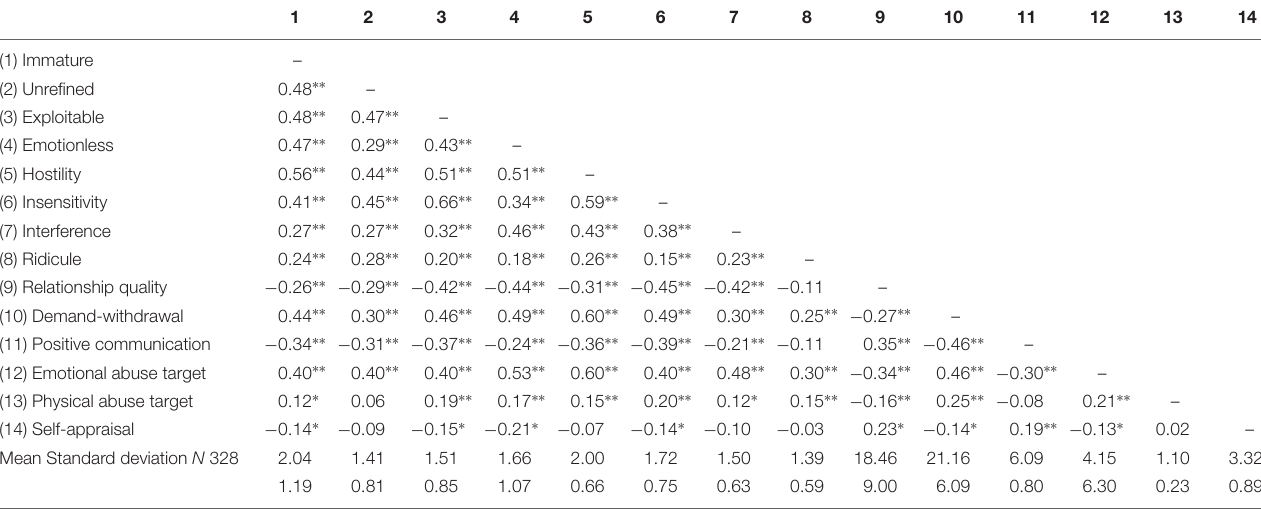
TABLE 6 | Study 3 descriptive statistics and zero-order correlations between the target version of the DIRRS and other study variables.